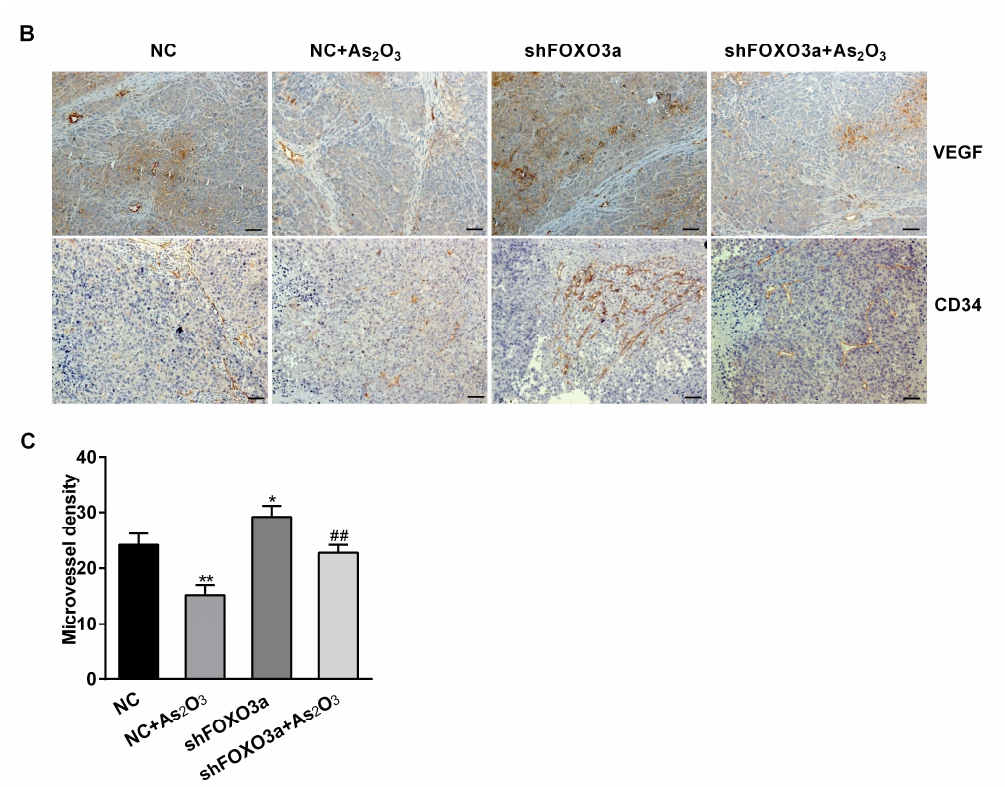
Figure 6. As 2 O 3 inhibited tumor angiogenesis through regulating FOXO3a in vivo. ( A ) HE staining and immunohistochemical staining were used to analyze the structural features and FOXO3a expression in tumor tissues. ( B ) Immunohistochemical staining was used to analyze the expression of VEGF and CD34 in tumor tissues. Scale bar, 50 µ m. ( C ) The microvessel density was evaluated by quantifying CD34 positive microvessels in tumor tissues. Compared with the NC group, * p < 0.05, ** p < 0.01; compared with NC + As 2 O 3 group, ## p < 0.01.